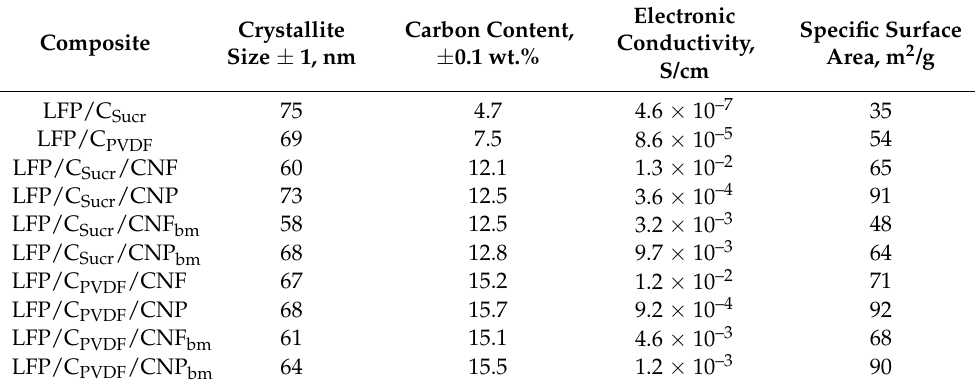
Table 1. Crystallite size (CSR), carbon content, electronic conductivity, and specific surface area values for the LFP/C/CNM composites. Crystallite Carbon Composite Size ± 1, nm